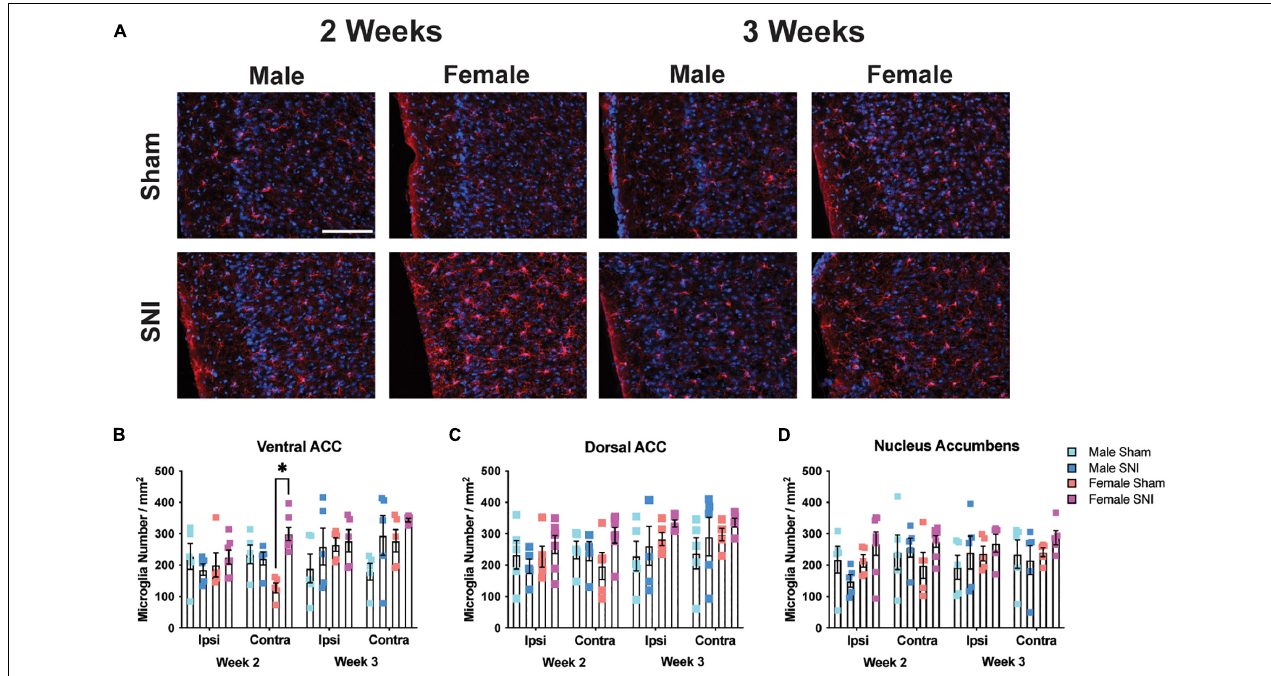
FIGURE 2 | Microglia changes in selected brain regions following SNI. (A) Representative fluorescent micrographs taken from the contralateral ventral ACC for male and female mice across surgery condition and timepoints. Scale bar = 100 µ M. (B) SNI increases microglial number in the contralateral ventral ACC 2-week post-surgery. Microglia remained elevated in female mice 3-week post-surgery but was no longer significant from the sham condition. SNI did not alter microglia numbers in the (C) dorsal ACC, or (D) nucleus accumbens ( n = 5–6/sex/condition, three tissue samples per mouse). ∗ p < 0.05.